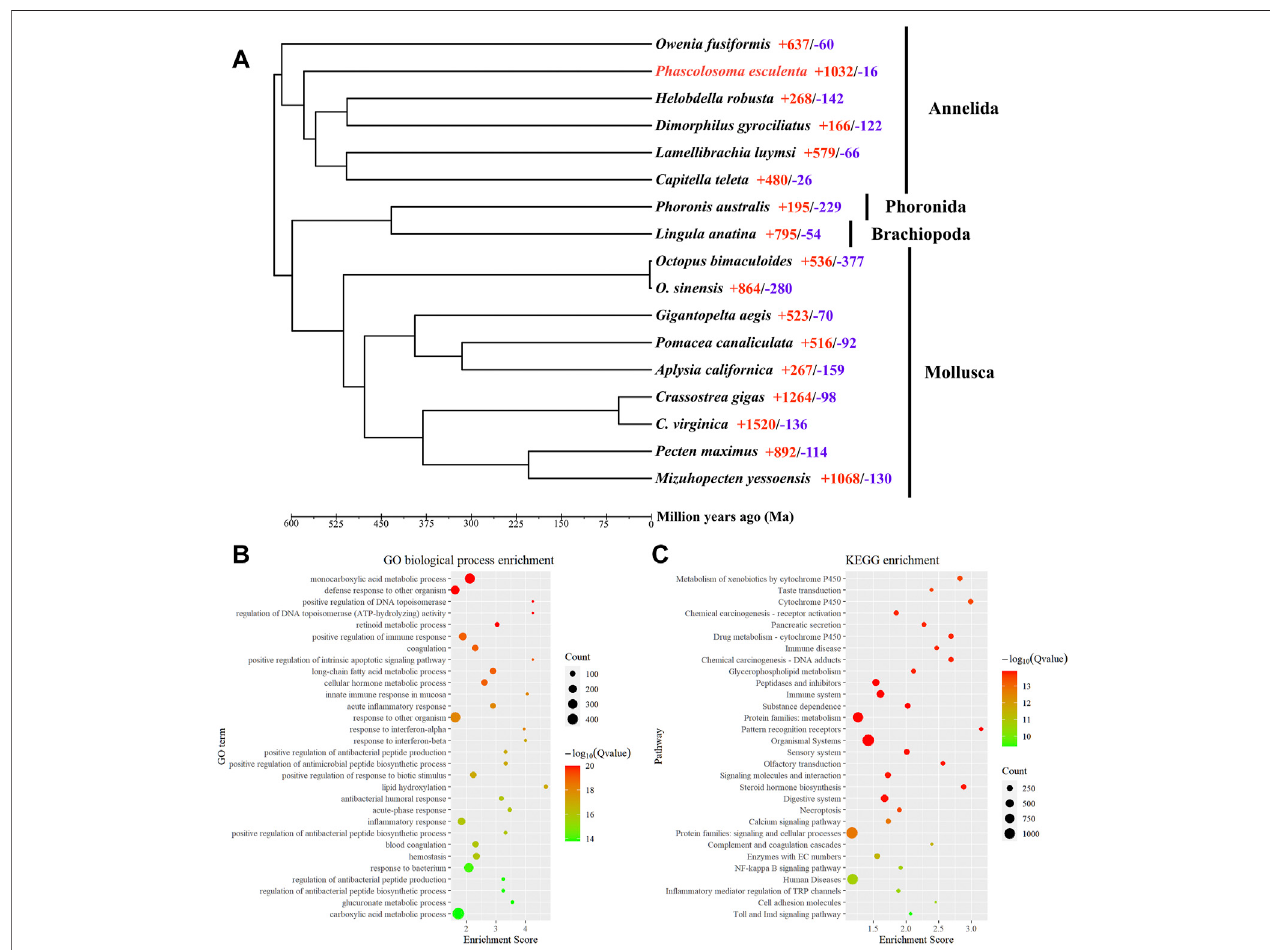
FIGURE 2 | Phylogeny, gene family evolution, and function enrichment analyses. (A) Phylogeny and gene family evolution. The number of signi fi cantly expanded (red) and contracted (blue) gene families is designated beside the species scienti fi c name. (B) Function enrichment of Gene Ontology (GO) for signi fi cantly expanded gene families. (C) Kyoto Encyclopedia of Genes and Genomes (KEGG) enrichment analysis for signi fi cantly expanded gene families. Only the top 30 categories are shown.